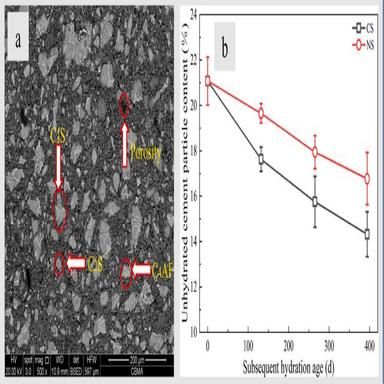
Unhydrated cement granule content analysis: (a) Distribution of different phase in BSE images; (b) Change curve of unhydrated cement granule content within the specimens.